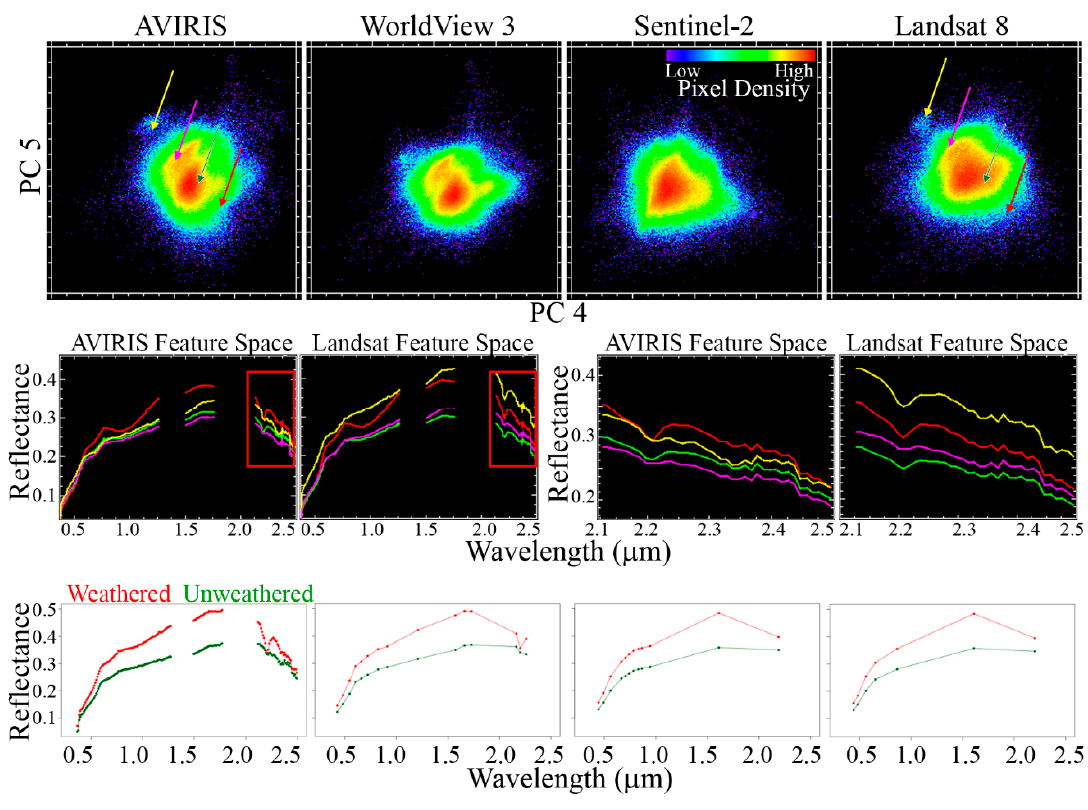
Figure A3. Spectral Feature Space. Top row: only the example of PC 4 vs 5 is shown for brevity. AVIRIS and Worldview 3 clearly demonstrate clustering in this projection, but Sentinel-2 and